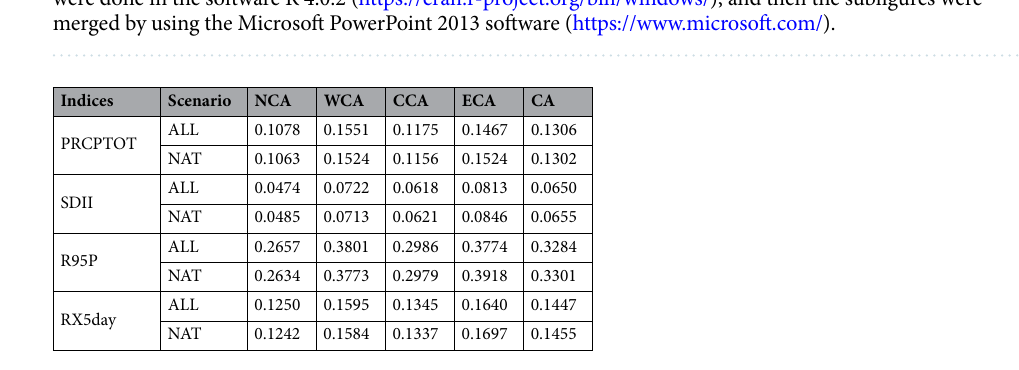
Table 1. Mean Gini values in 4 sub-regions and the whole of CA for the historical